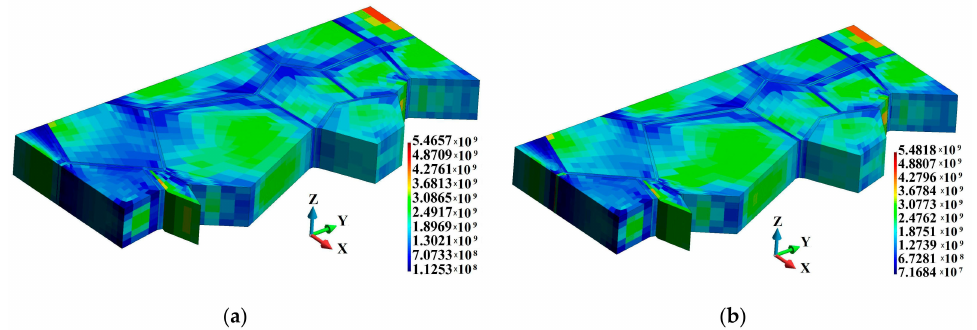
Figure 8. Huber-Mises-Hencky stress (Pa) in the cross-section along the grains: ( a ) Adiabatic solution; ( b ) coupled solution.